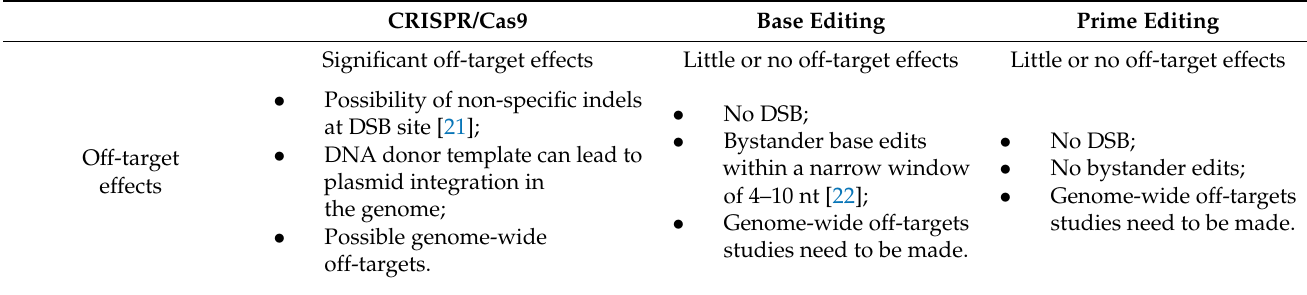
Table 1. Comparison of advantages and disadvantages of CRISPR/Cas9, base editing, and prime editing